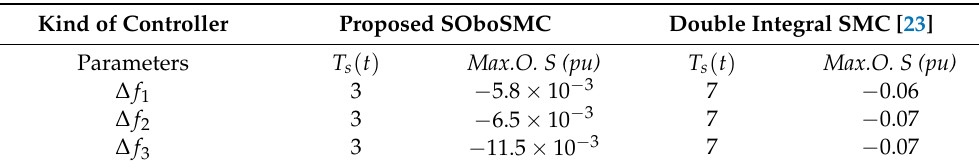
Table 1. Setting time and maximum overshoot of the proposed state observer based on sliding mode control (SOboSMC) and double-integral SMC [23].